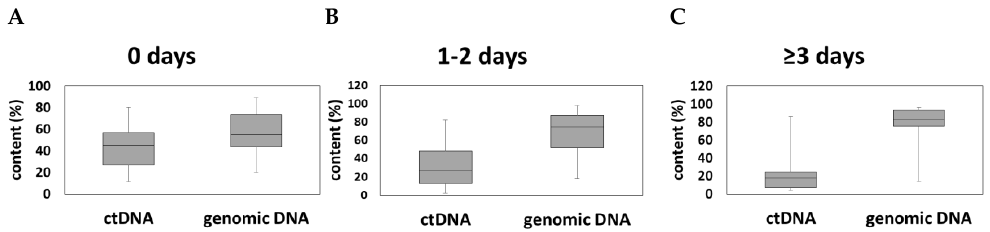
Figure 3. Delay in plasma preparation leads to increased plasma DNA contamination. CtDNA content and content of genomic DNA from plasma DNA samples isolated ( A ) at the same day, ( B ) at 1–2 days and ( C ) at ≥3 days after venipuncture.